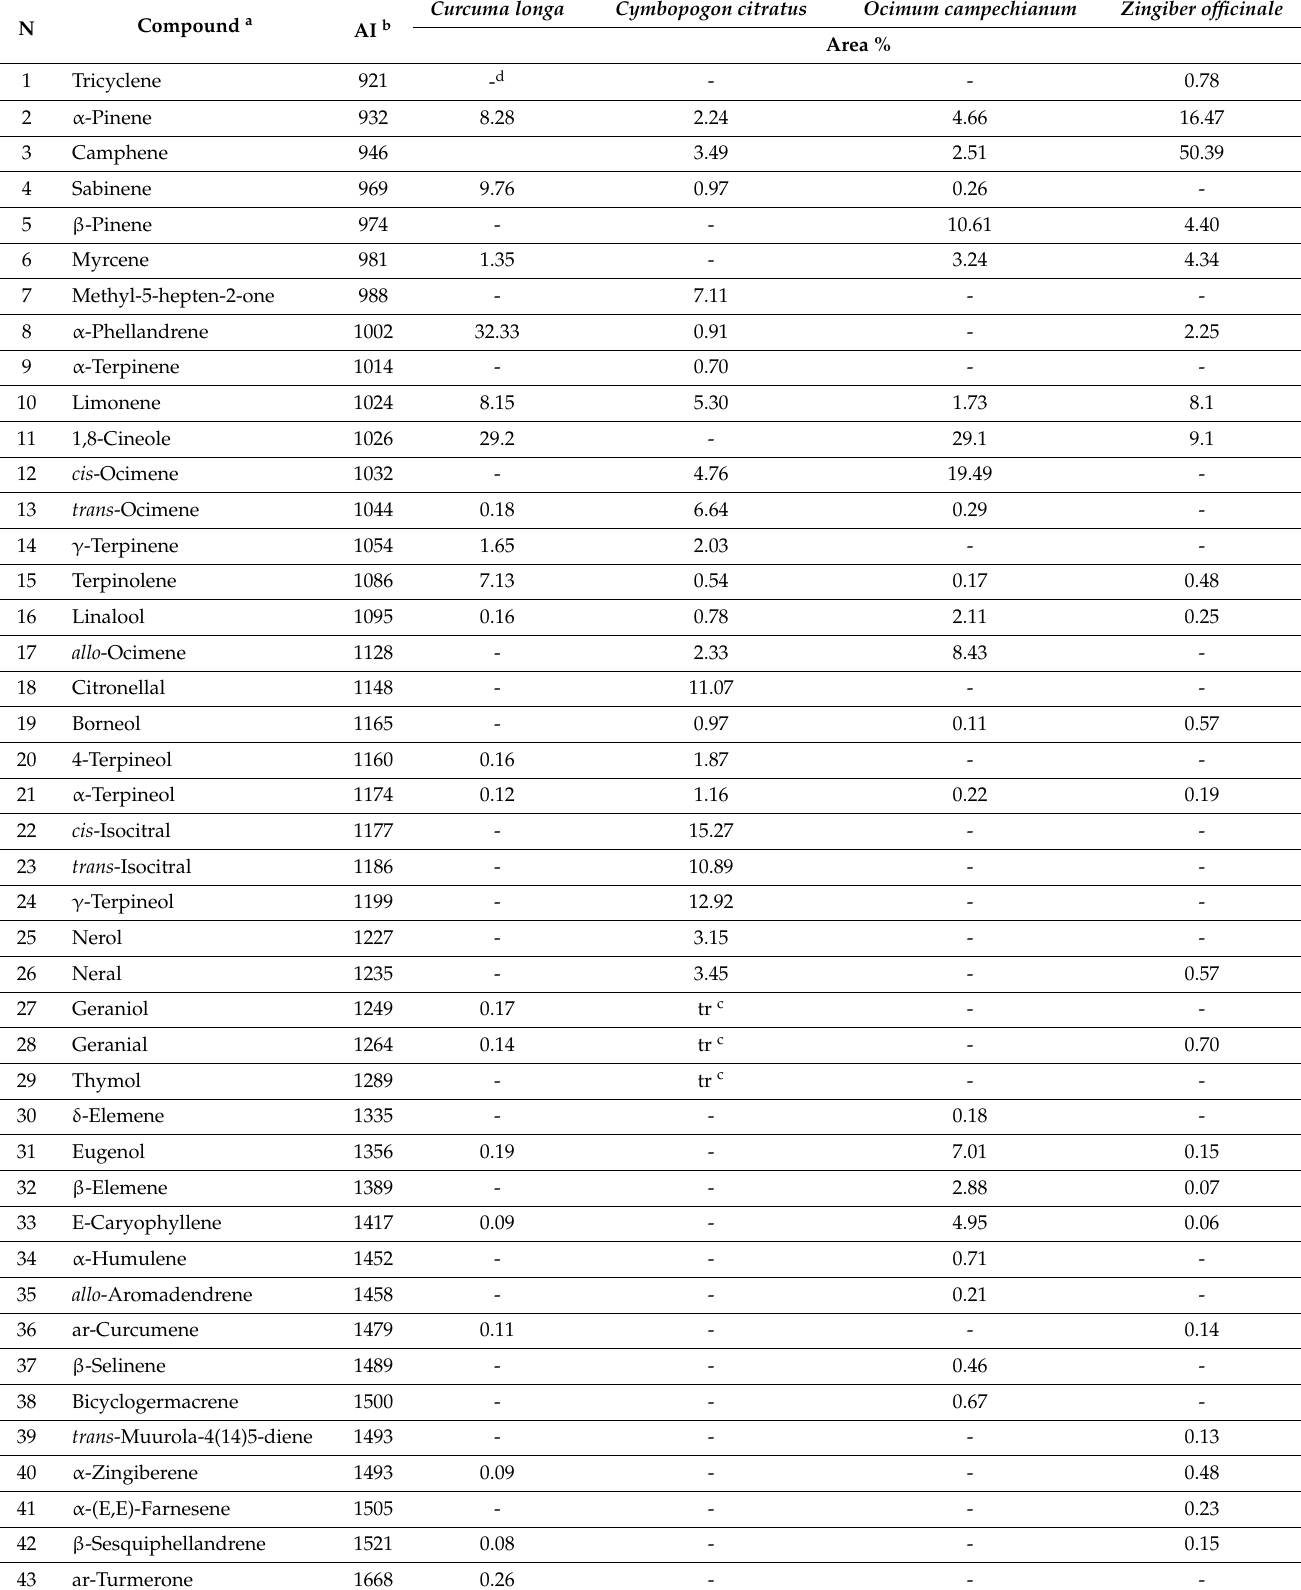
Table 3. Headspace composition of Amazonian essential oils (EOs) through GC and GC-MS